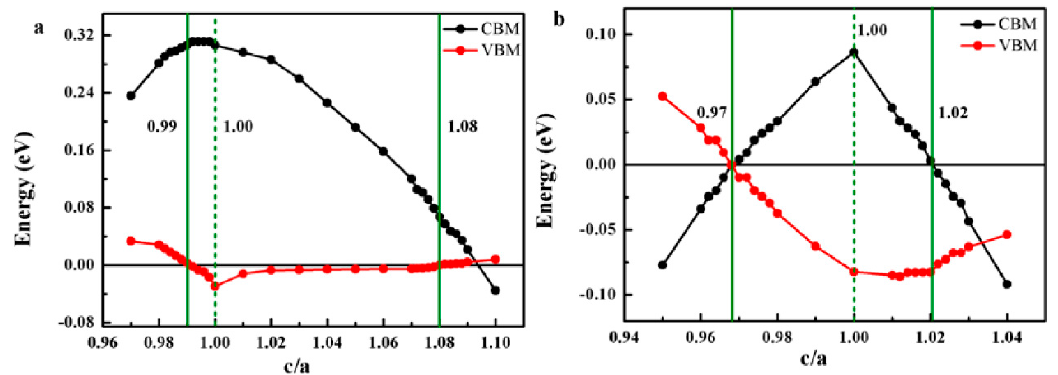
Figure 7. The CBM and VBM in the majority spin channel as functions of c/a ratios for ( a ) FeRhCrSi and ( b ) FePdCrSi compounds.